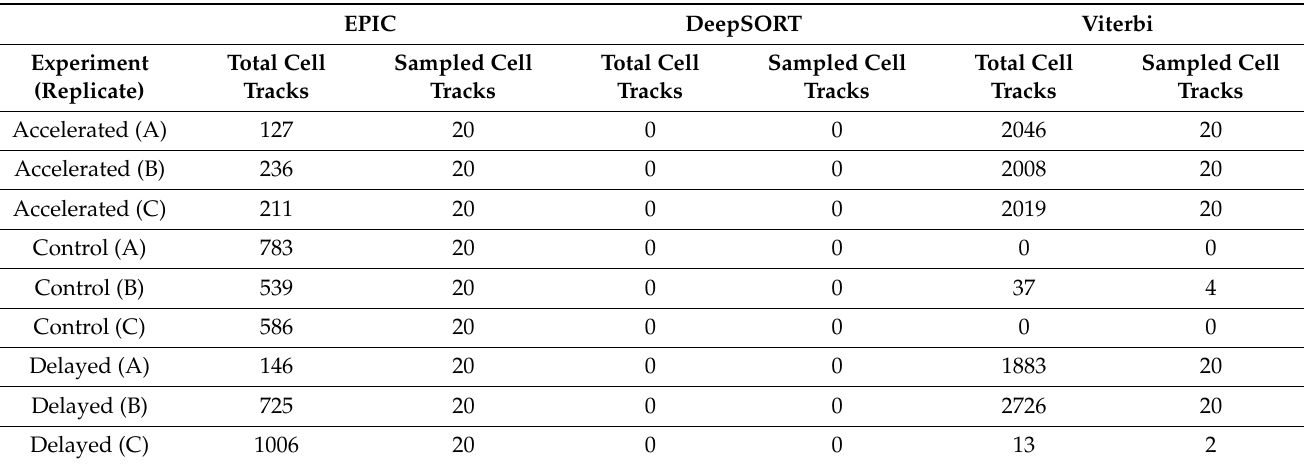
Table 1. A summary of the number of cells tracked from the 1st to the 22nd frame without fragmenta- tion by EPIC, DeepSORT and